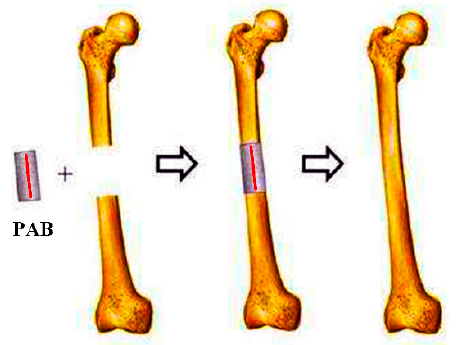
Figure 2. Polylactic acid (PLA) artificial bone (PAB) prototype applied to repair a bone defect (red line is the magnetoelasticity-based (MB) sensor).